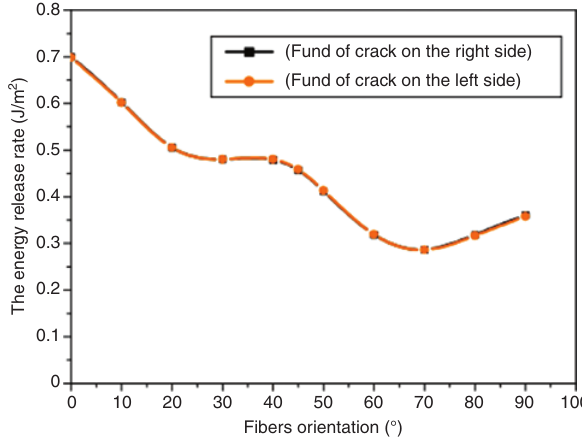
Figure 7: Variation of energy release rate according of the fiber orientation for both fund of crack.